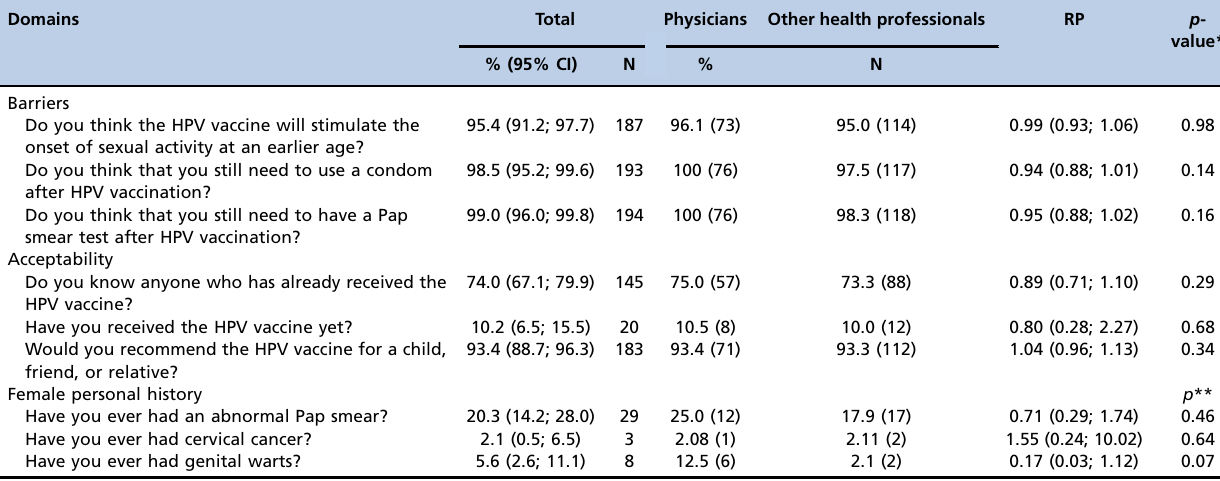
Table 3 - Barriers, acceptability, and personal antecedents related to the HPV vaccine among physicians and other health professionals interviewed in the Health Care System for Women and Children (SASMC) in the state of Acre, Brazil, in 2017. Domains